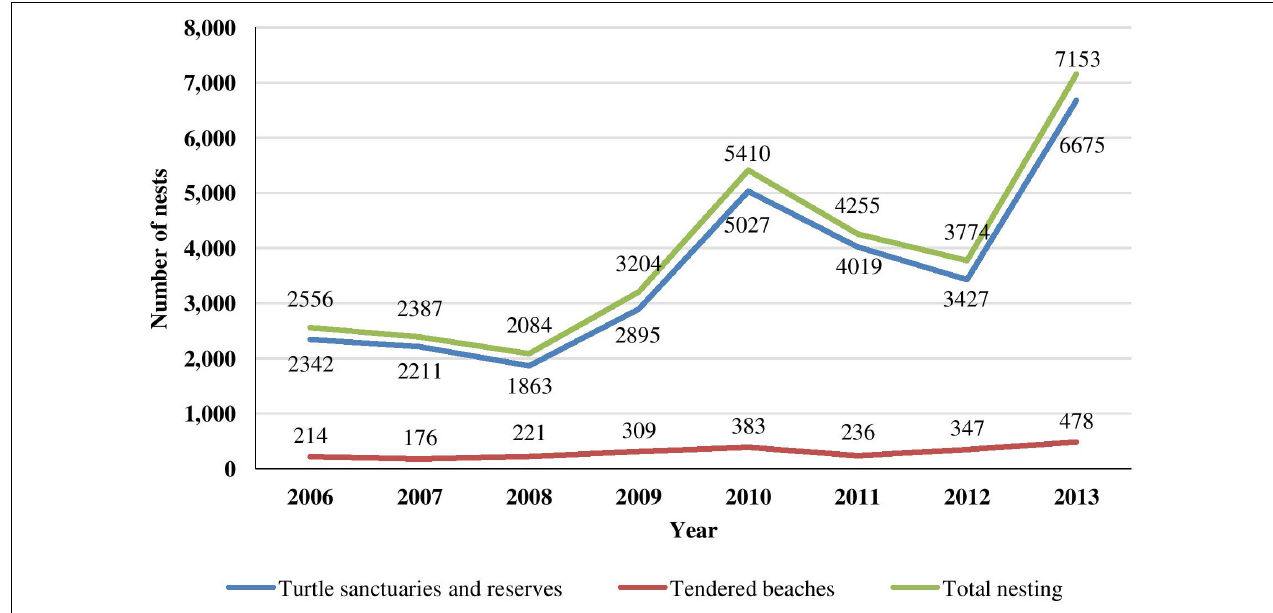
FIGURE 3 | Green turtle nesting record based on beach classification in Terengganu from 2006 until